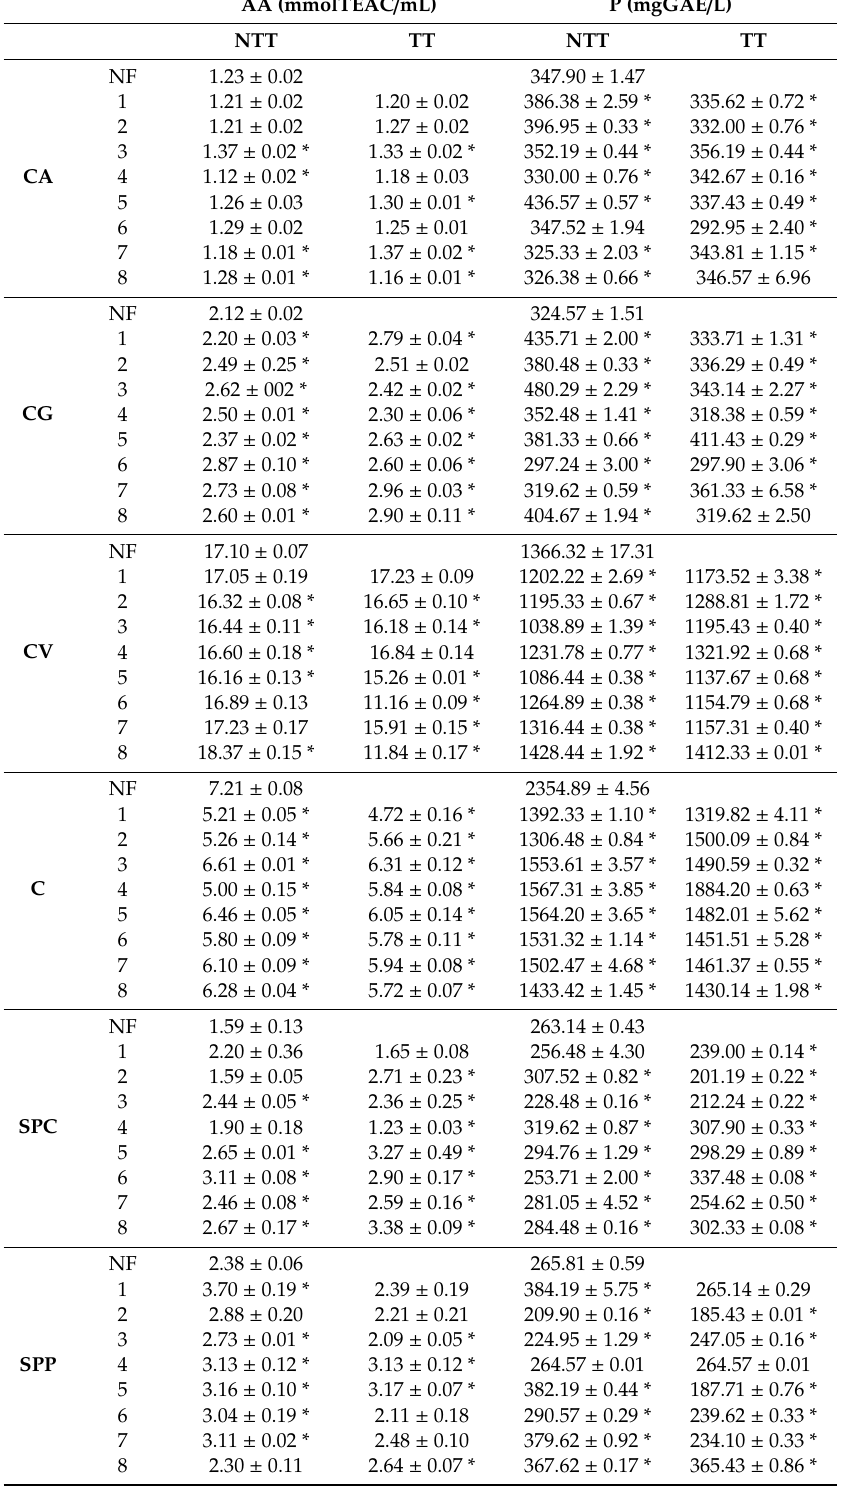
Table 2. Results from antioxidant activity (AA) and quantification of total polyphenols (P). Average value ± standard deviation are reported for refrigerated (NTT) and pasteurized samples (TT) with regard to the control unfermented (NF). * significant ( p < 0.05) di ff erences in comparison with unfermented